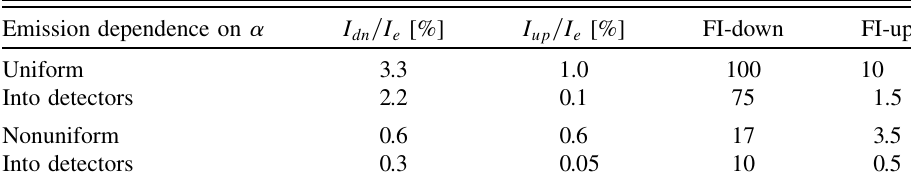
TABLE I. Fraction of emitted dark current leaving ends of the structure, and reaching the detectors (first 2 columns); the 11.4 GHz component of the absolute value of the Fourier integral of the exiting currents (in arbitrary units, last 2 columns).